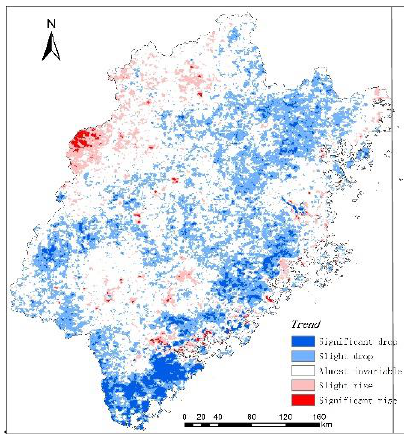
Figure 4. 15 years LST trend from 2001 to 2015